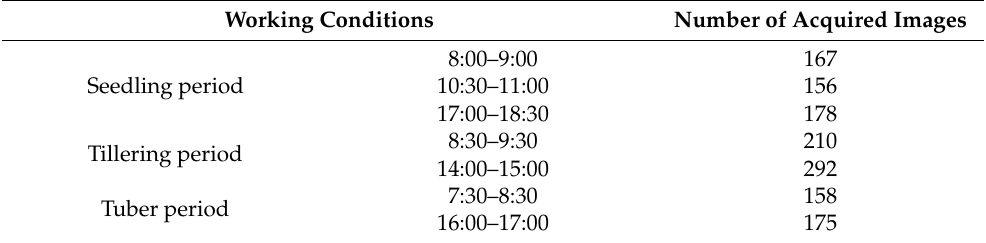
Table 1. Number of images collected under different working conditions.